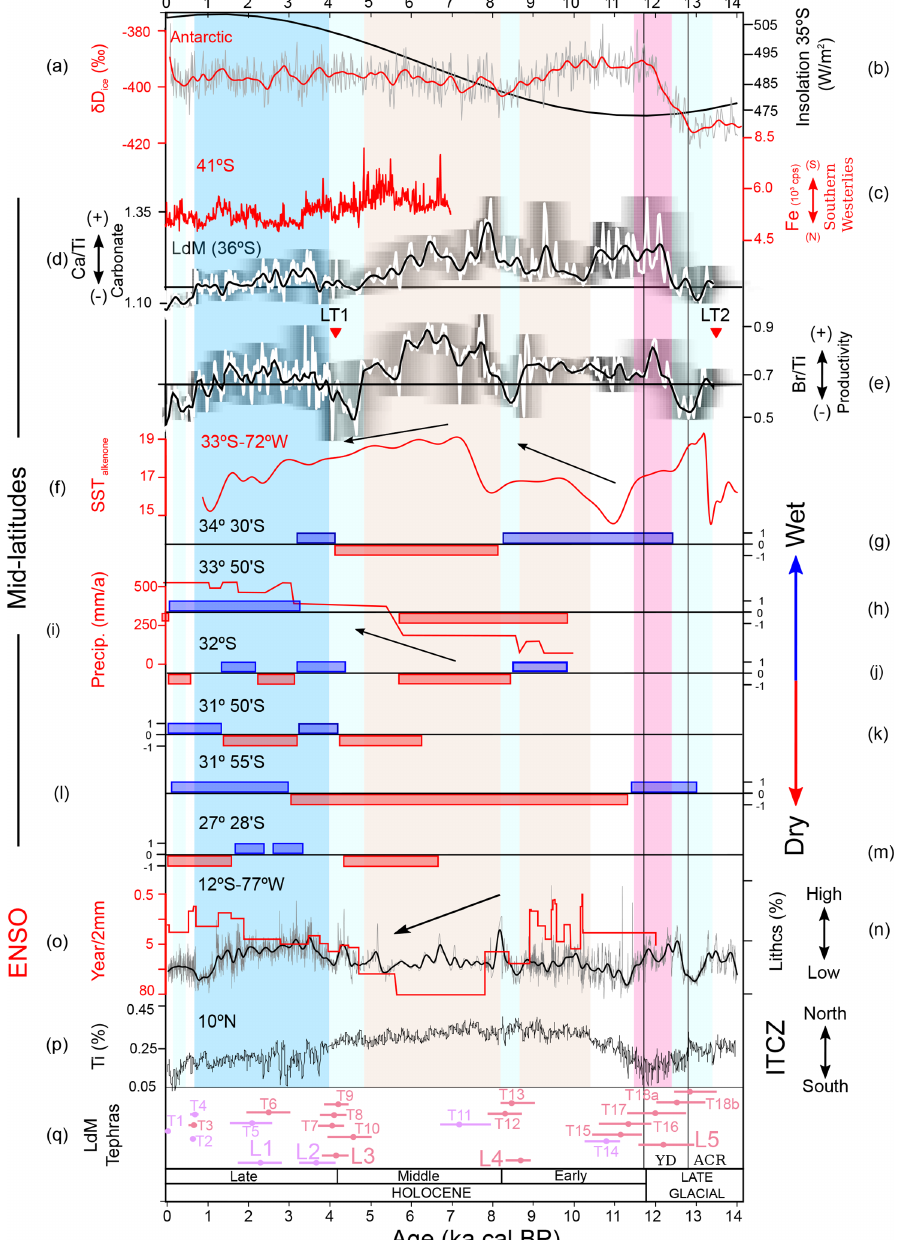
Figure 8. Comparison of selected proxies in the LdM sequence with representative local, regional and global paleoclimate records. (a) Dome C ( δ D) ice core record (Jouzel et al., 2007). (b) Southern Hemisphere summer (Wm − 2 ) insolation to 35 ◦ S (Berger and Loutre, 1991). (c) Iron contents of core GeoB 3313-1 (Lamy et al., 2002). (d, e) Carbonate (Ca / Ti) and total organic productivity (Br / Ti) of the LdM sequence; shading indicates age model uncertainty. (f) Sea surface temperatures (SST alkenone ) from the continental slope off mid- latitude Chile (Kim et al., 2002) at ∼ 33 ◦ S. (g–n) Categorization of the moist conditions interpreted by Holocene paleoclimate records Lake Jenny et al., 2002, 2003. (j) Palo Colorado (Maldonado and Villagrán, 2006). (k) Ñague Swamp Forest (Maldonado and Villagrán, 2006). (l) Quereo Swamp Forest (Villagrán and Varela, 1990; Villa-Martínez and Villagrán, 1997). (m) Negro Francisco Lake (Grosjean et al., 1997). (n, o) Holocene marine record, ENSO-sensitive, from Peruvian shelf (Rein et al., 2005). (p) Bulk Ti content of Cariaco